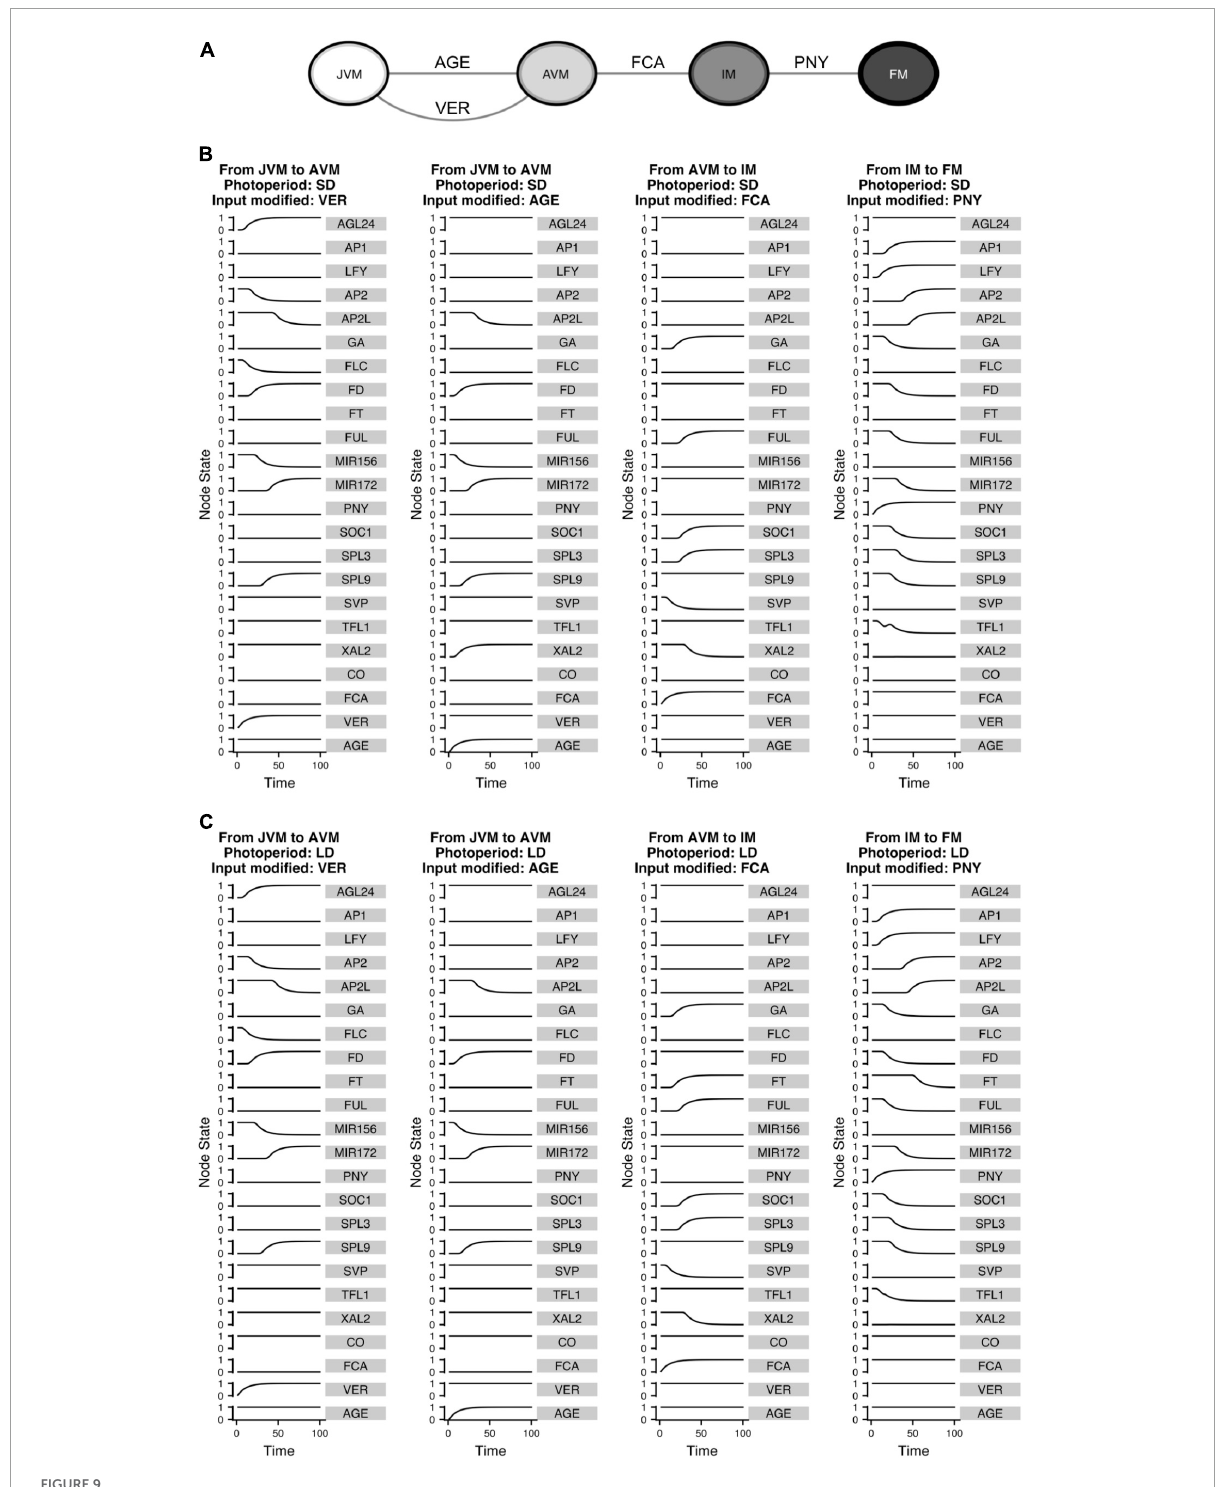
FIGURE9 The FT-GRN underlying signal sensing and integration drives the developmental trajectories from the vegetative to the reproductive stage of development. (A) Turning “ON” the input nodes can drive the system from one phenotype to another, recovering the temporal sequence of differentiation in response to environmental (VER), endogenous (AGE and FCA), and spatial (PNY) signals. Differentiation simulations for (B) SD and (C) LD photoperiods, the VER and AGE nodes drive the temporal progression from JVM to AVM; while upregulation of FCA drive the system from the AVM to the IM stage and increasing PNY drives the IM to the FM